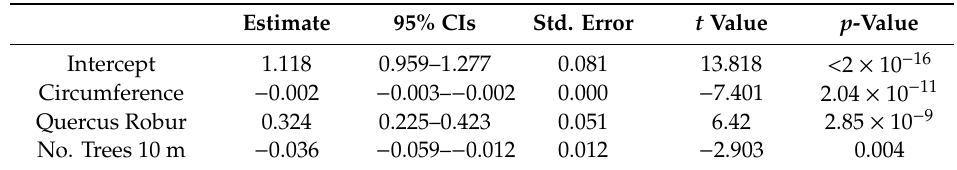
Table 1. Estimated regression parameters, 95% confidence intervals, standard errors, t values and p - values for the minimum adequate Gamma distributed model. Nagelkerke’s R 2 = 0.546, Cox and Snell’s R 2 = 0.496. Intercept = combined factor levels of Quercus cerris / rubra / palustris .